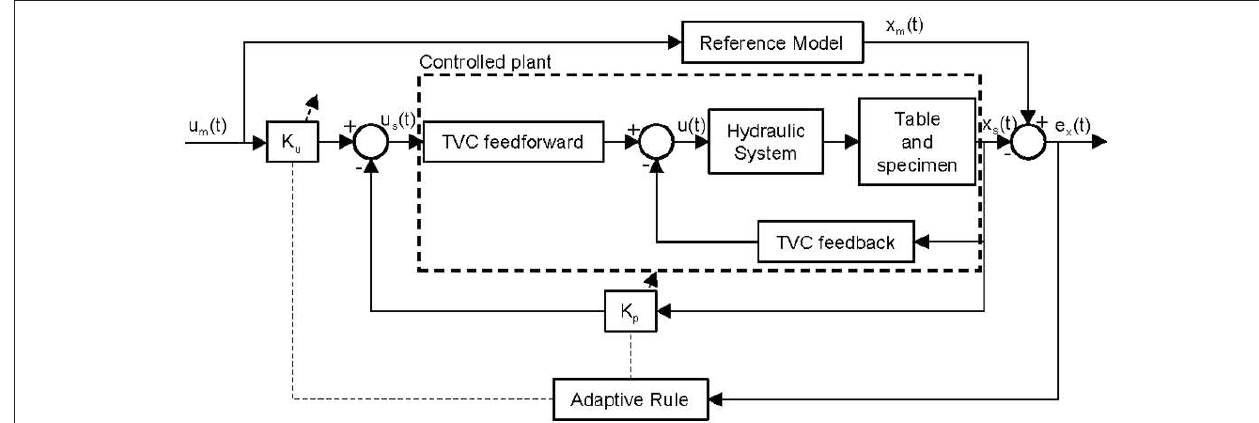
FIGURE 4 | Block diagram of proposed control Strategy.